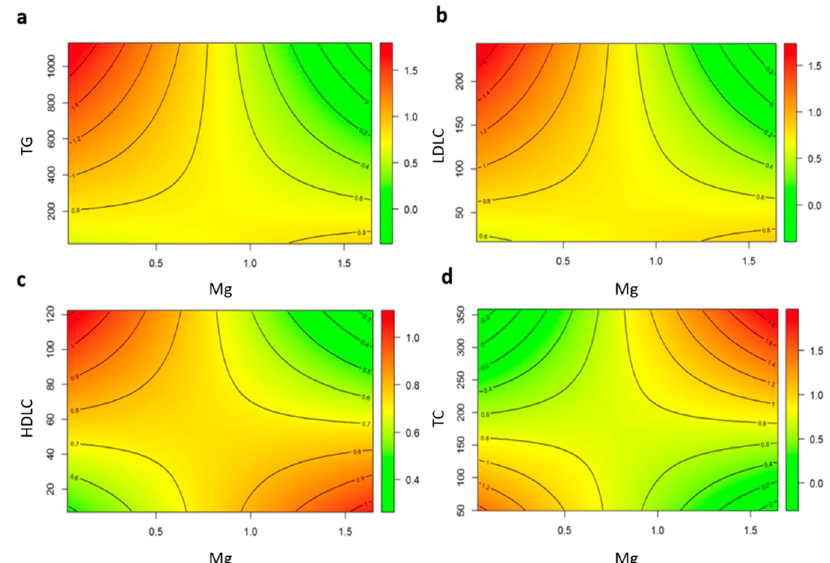
Figure 1. Interaction Graphs for Continuous Data. ( a ) Predicted cIMT with different levels of triglycerides (TG) and magnesium (Mg). ( b ) Predicted cIMT with different levels of LDL cholesterol (LDLC) and magnesium. ( c ) Predicted cIMT with different levels of HDL cholesterol (HDLC) and magnesium. ( d ) Predicted cIMT with different levels of total cholesterol (TC) and magnesium.